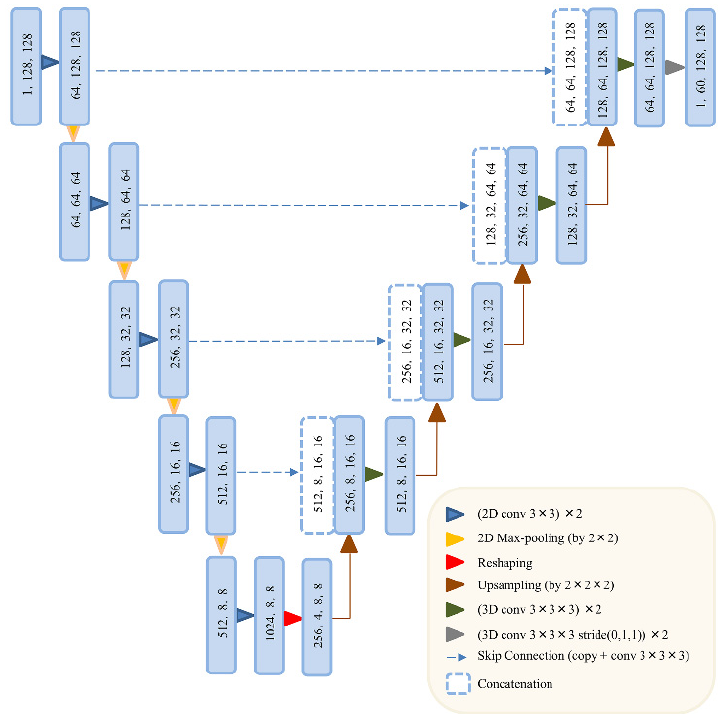
Figure 3. The architecture of our proposed network. The meaning of all types of signs is marked at the bottom right of the figure. the bottom right of the